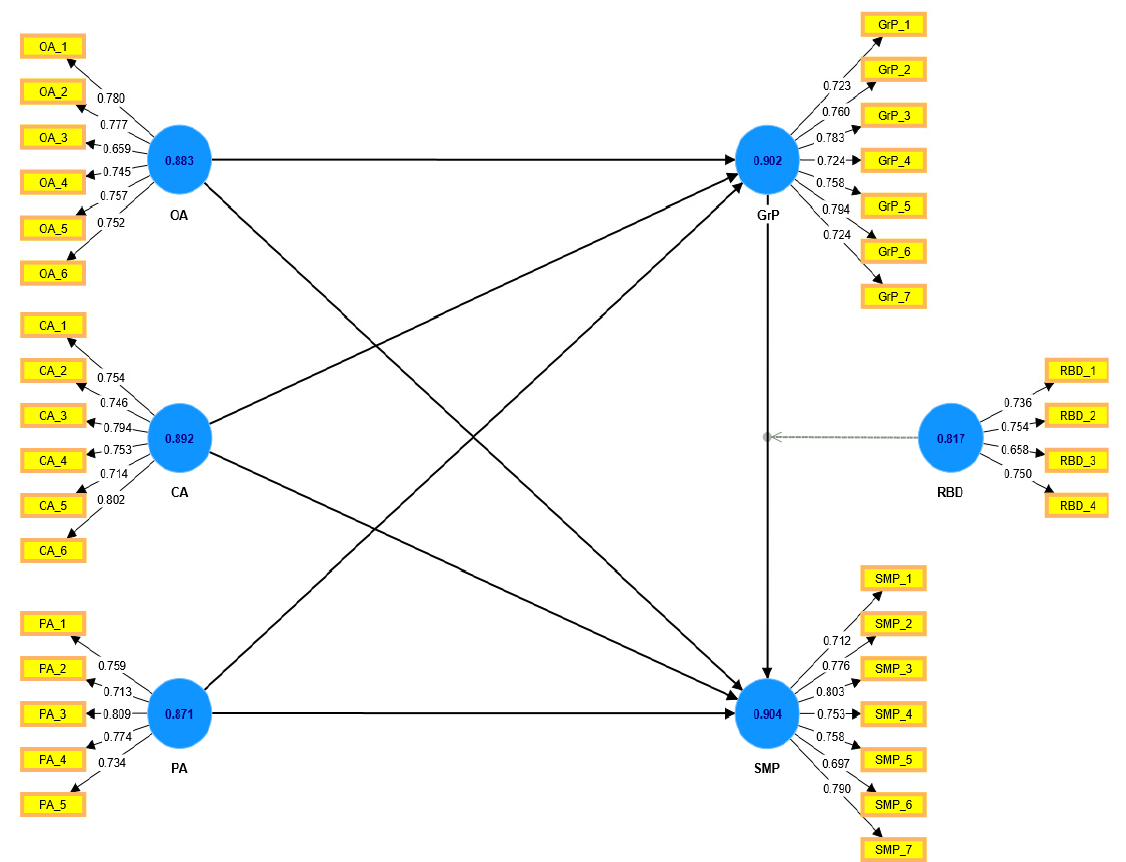
Figure 2. Assessment of Measurement Model.